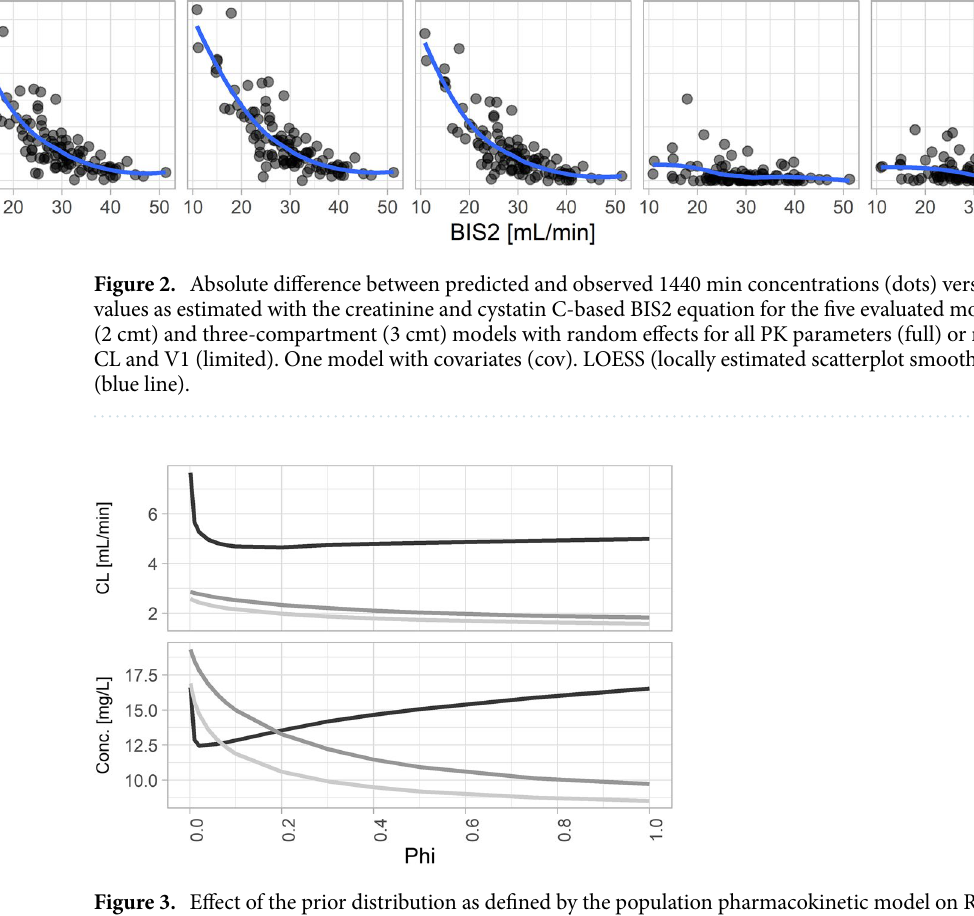
Figure 3. Effect of the prior distribution as defined by the population pharmacokinetic model on RMSE concerning clearance (CL) and iohexol concentration predictions 1440 min post injection (Conc.) The three- compartment model with a simplified random effects structure and with (light gray) or without (dark gray) covariates performed best with an undiscounted prior ( φ = 1 ). Both models performed better than the three- compartment model with random effects for all pharmacokinetic parameters